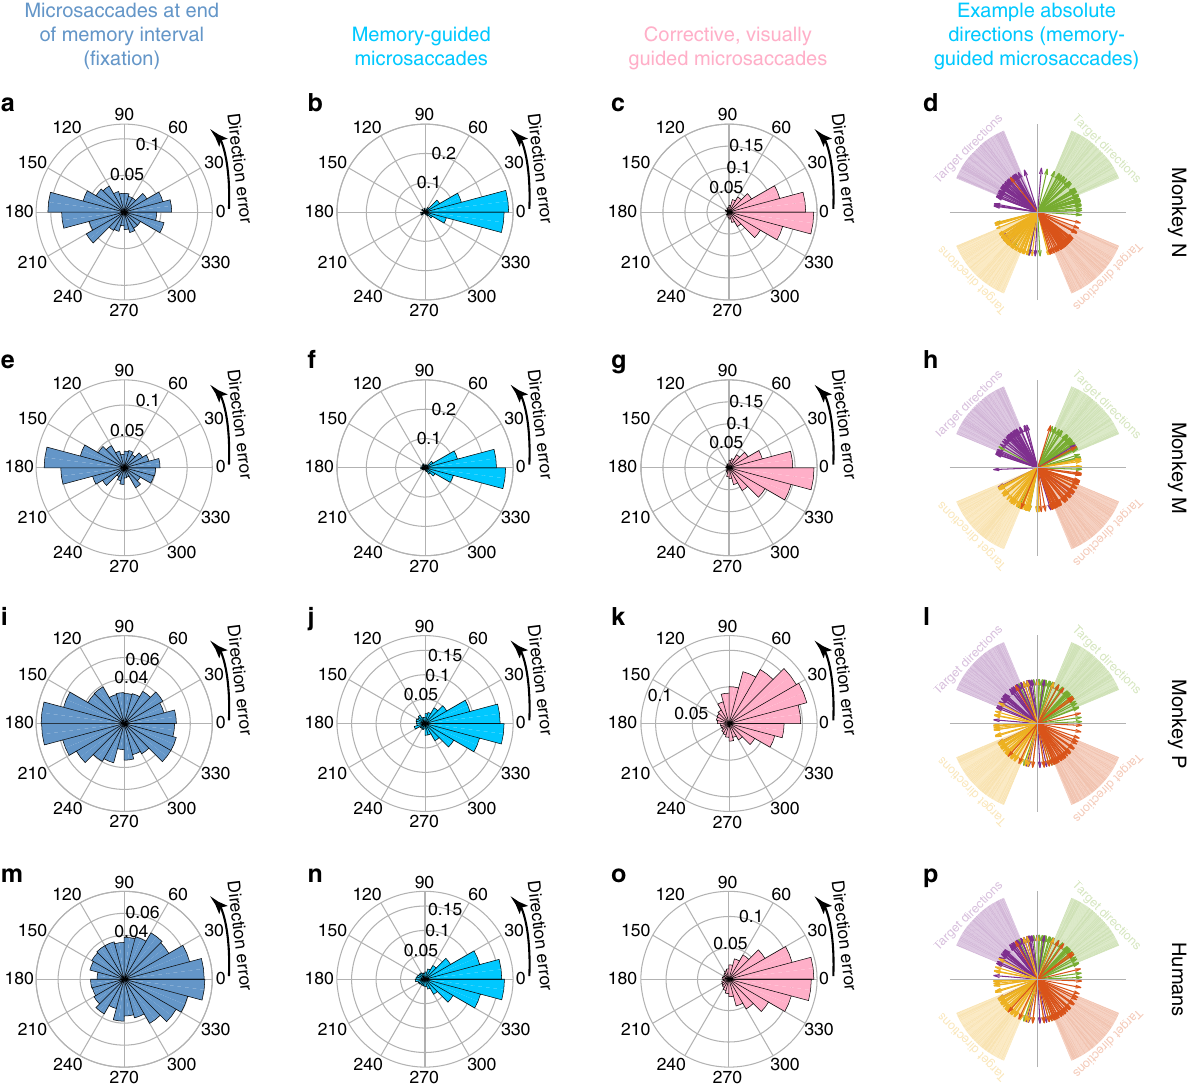
Fig. 3 Memory-guided microsaccades had better directional accuracy than either microsaccades during fi xation or corrective, visually-guided microsaccades. a We plotted the angular distribution of microsaccade direction error (that is, the difference between target direction and microsaccade direction; Methods). In this measure, if a microsaccade has the same direction as the target direction, then the movement has zero direction error. In this panel, this measure is shown for all microsaccades from monkey N occurring in the fi nal 250 ms of fi xation before fi xation spot disappearance. Microsaccades could occur either towards or away from the remembered target location. The histogram was normalized by the total number of observations. b The same monkey exhibited highly accurate microsaccade directions toward the remembered target location when explicitly instructed to do so. c After target reappearance, corrective, visually-guided microsaccades were also target-directed, but their direction errors were signi fi cantly more variable than the instructed movements in b (see statistics in text). Thus, instructed memory-guided microsaccades were highly directionally accurate. d Each group of colored arrows shows the directions of 40 randomly selected memory-guided microsaccades when remembered target directions were drawn from the underlying corresponding-colored faint cone. Directionally accurate microsaccades could be generated for all oblique target directions. e – h Similar observations for monkey M. i – l Similar observations for monkey P. m – p Similar observations for our human subjects. In all cases, directional accuracy was the highest for the instructed, memory-guided movements and not for fi xational microsaccades ( a , e , i , m ) or corrective, visually guided ones ( c , g , k , o ); also see Supplementary Fig. 3 for fl ash-induced microsaccades. For the leftmost column, n = 1,432, 2,875, 4,870, 2,831 microsaccades for monkey N, monkey M, monkey P, and the human subjects, respectively. The numbers of trials for memory-guided or corrective, visually guided microsaccades are the same as in Fig. memory-guided microsaccades (Fig. 3b, f, j, n) ( p < 10 − 50 for